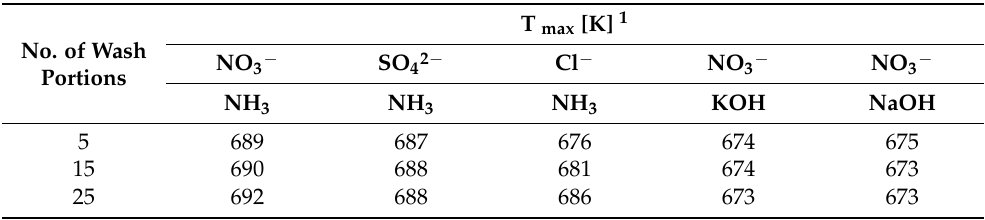
Table 6. Maximum temperature of decomposition of Mg(OH) 2 samples obtained using three different counterions and three precipitating